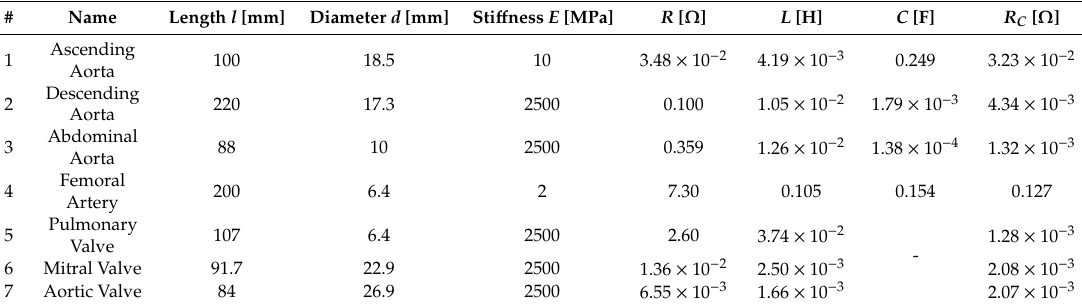
Table 2. Parameters of cardiovascular components.